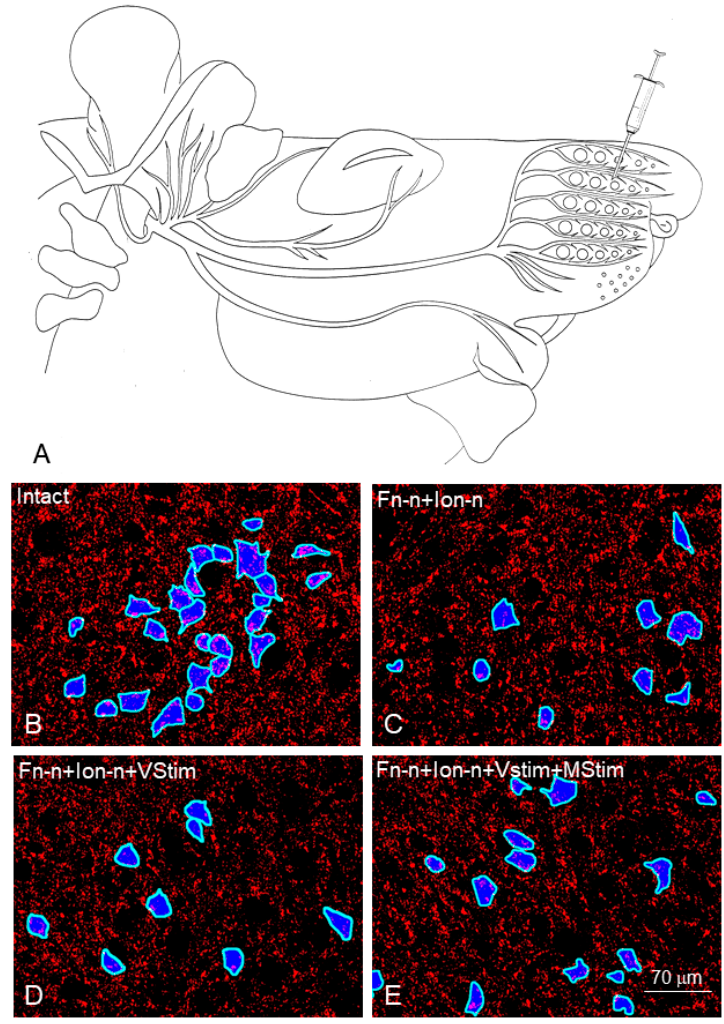
Figure 5. ( A ): Schematic drawing indicating the injection site of the retrograde tracer Fast Blue (FB; syringe) into the whisker pad. ( B – E ): Retrogradely labelled motoneuronal perikarya (blue) and synaptophysin-CY3 immunostaining of axosomatic nerve boutons in the intact facial nucleus ( B ), four months after Fn-n + Ion-n ( C ), after Fn-n + Ion-n + Vstim ( D ) and after Fn-n + Ion-n + Vstim + Mstim. FB-images were used to define “regions of interest” (RoIs) in each picture of the facial nucleus (ImageJ Software v1.38, NIH, Bethesda, MD, USA) through the following steps: (1) The dynamic range of the FB-images was maximized using gamma correction ( γ = 0.2); (2) Images were sharpened by subtraction of a blurred copy (Gaussian blurring radius = 75 px); (3) Images were automatically thresholded using the Otsu algorithm to produce binary black and white images; (4) Motoneurons were included by selecting only FB-labelled areas with a value equal or greater than 500 µ m 2 . (5) The resulting masks were used to measure the perimeter and area of the selected motoneurons. The perimeters were drawn and expanded in and out by 2 px, which generated RoIs from the closest perisomatic vicinity of the motoneurons with a width of 5 px ( ≈ 4 µ m). All synaptophysin-positive profiles found within each of the predefined perisomatic RoIs of the thresholded images were counted, and the “numbers of perisomatic synapses per motoneuron” determined. From Bendella et al. (2011)